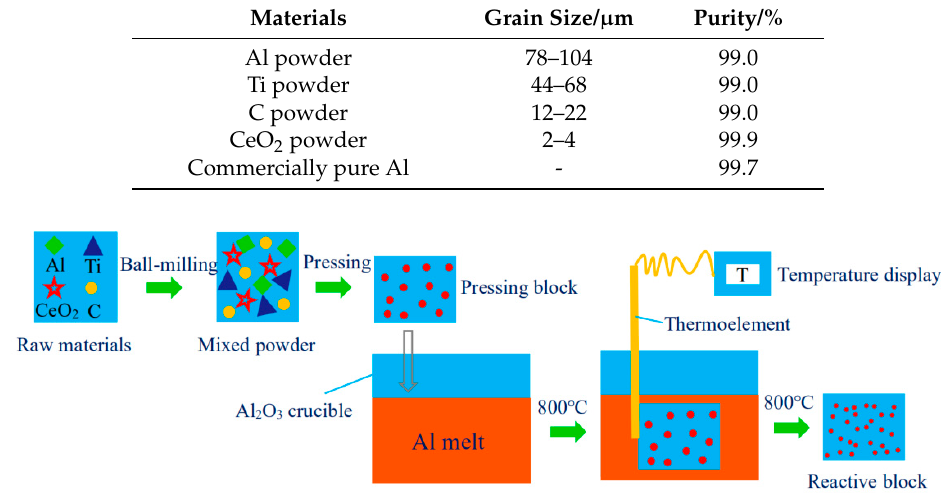
Figure 1. Experimental flow chart.